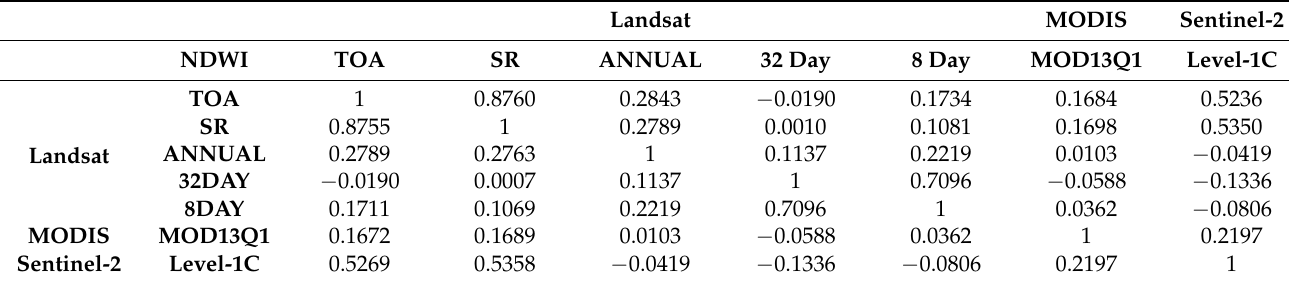
Table 4. Pearson correlation analysis of NDWI with different